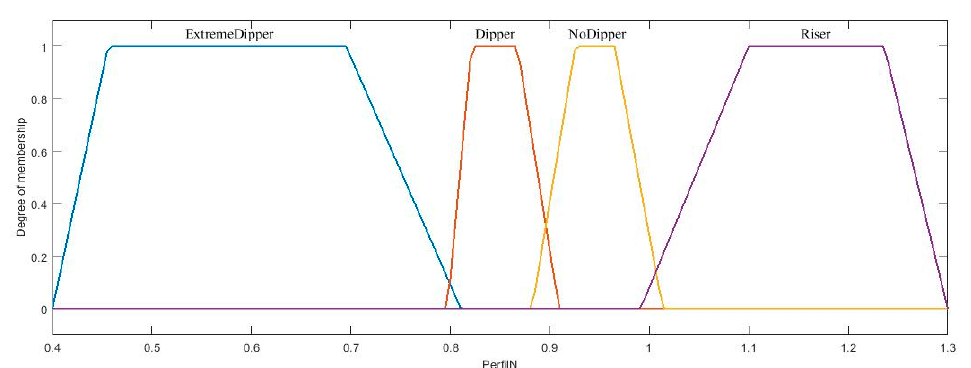
Figure 20. Optimized nocturnal blood pressure output.